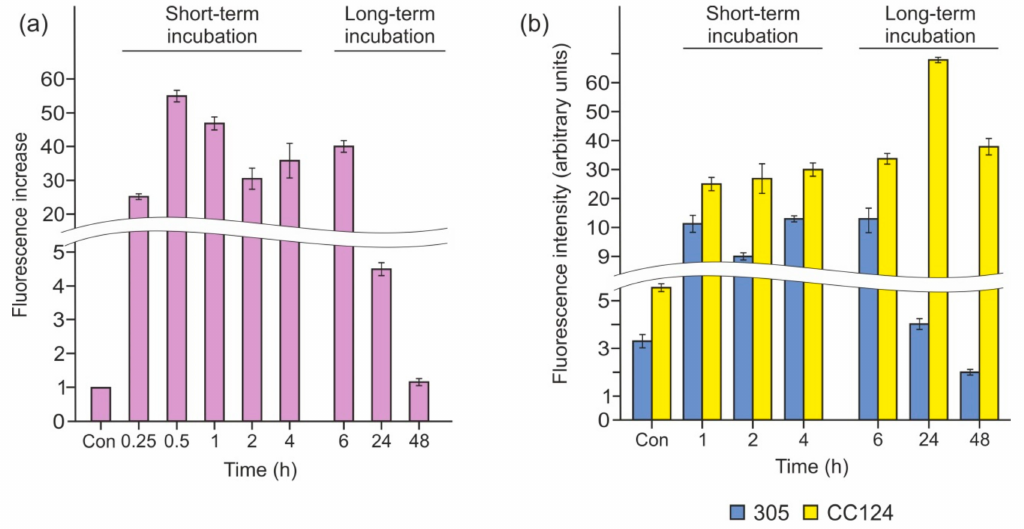
Figure 4. Nitric oxide (NO) generation following the removal of P from the medium. ( a ) Fluorescence increase was measured in the cw15-325 strain following the removal of P from the medium. Fluorescence intensity due to intracellular NO was determined using 1 µ M -amino-5-methylamino-2 (cid:48) 7 (cid:48) -difluorofluorescein diacetate dye (DAF-FM DA), and fluorescence in tris-acetate-phosphate (TAP) was used as control. The increase in fluorescence at each time point of incubation in P-free medium is shown. Data are the means ± SE from three biological replicates. ( b ) Fluorescence increase was measured in the CC124 and 305 strains following incubation in TA medium. Fluorescence intensity was expressed as arbitrary units per chlorophyll cells 10 − 6 . Cell autofluorescence was subtracted from the total fluorescence obtained. In ( a , b ), the production of NO was detected by the microplate reader CLARIOstar